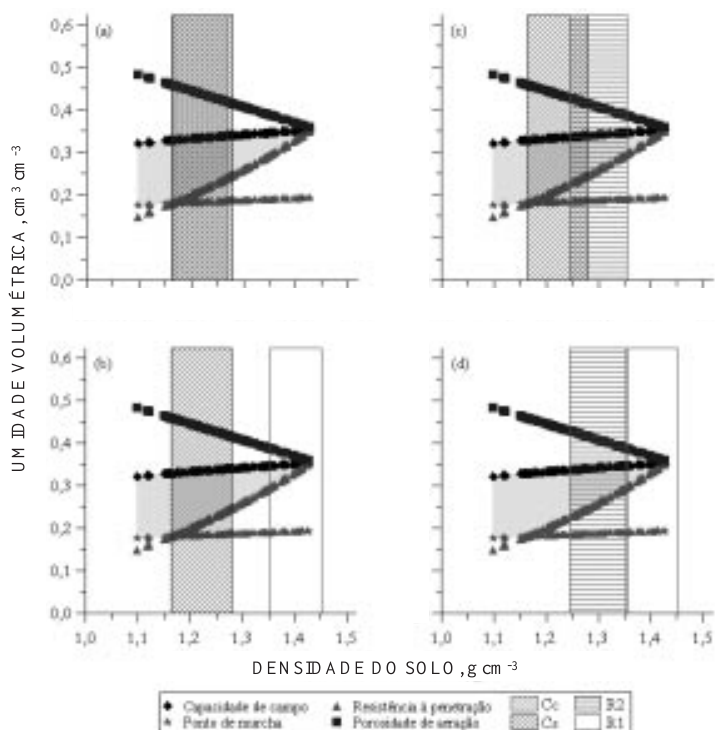
Figura 2. Comparação entre os tratamentos avaliados: (a) Cc e Cs; (b) Cs e R1; (c) Cs e R2; e (d) R1 e R2, através do critério do Intervalo Hídrico Ótimo (IHO). A área hachurada corresponde ao IHO e as colunas verticais correspondem à média dos valores de Ds ± um